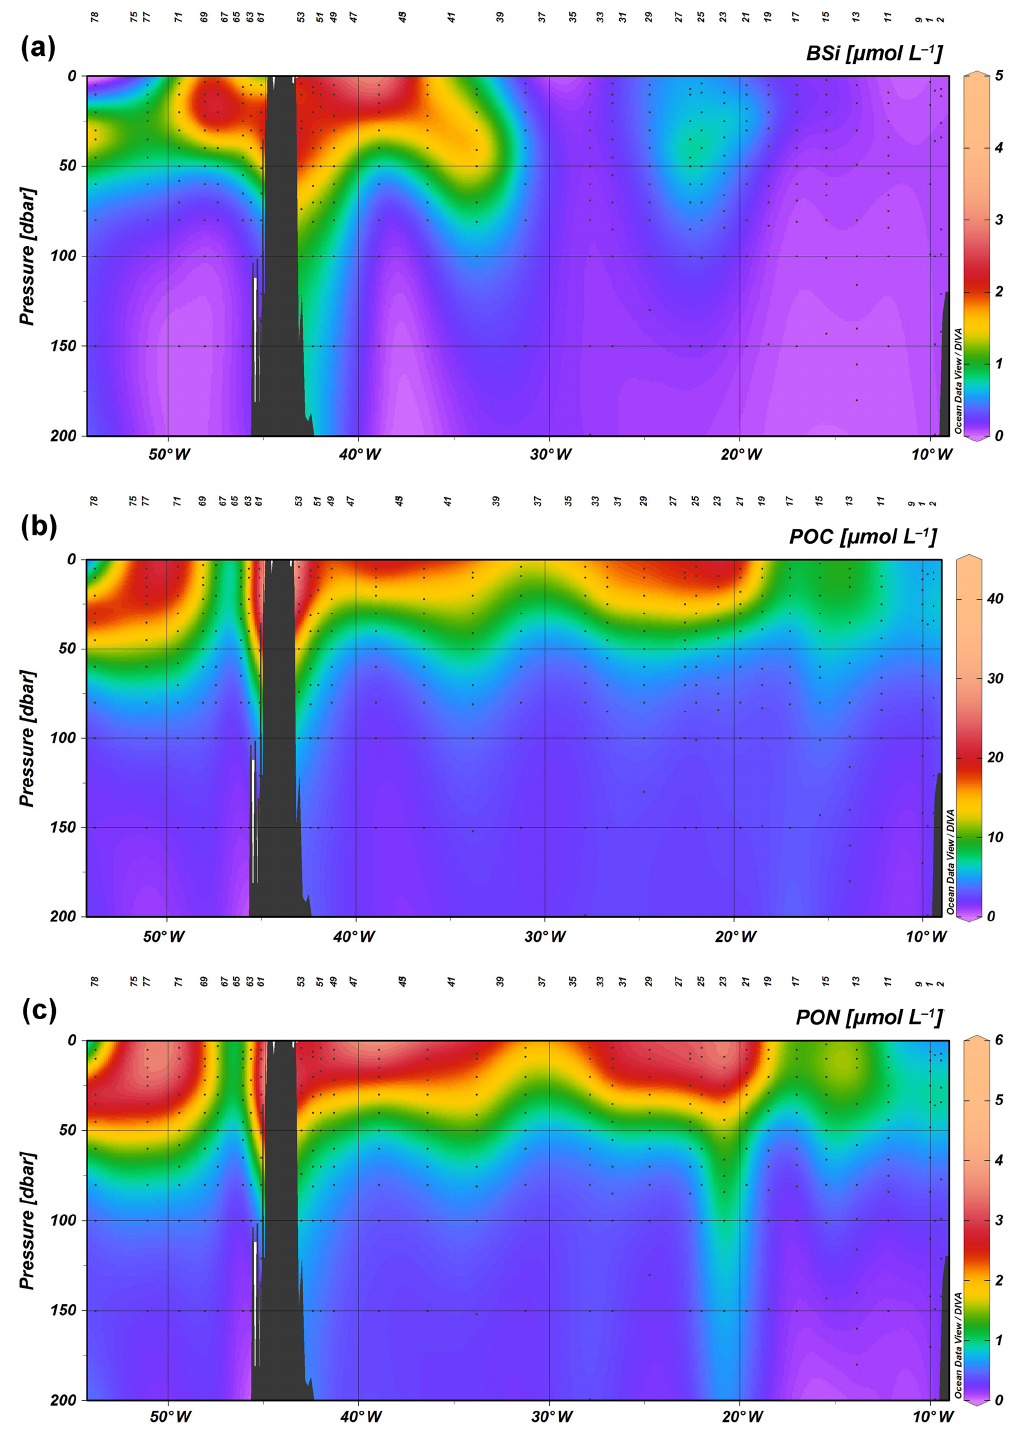
Figure 3. Section plots for (a) biogenic silica (BSi, µmolL − 1 ), (b) particulate organic carbon (POC, µmolL − 1 ), and (c) particulate organic nitrogen (PON, µmolL − 1 ), during the GEOVIDE cruise. Station locations are indicated by the numbers at the top of the panel. These plots were generated by Ocean Data View (Schlitzer,